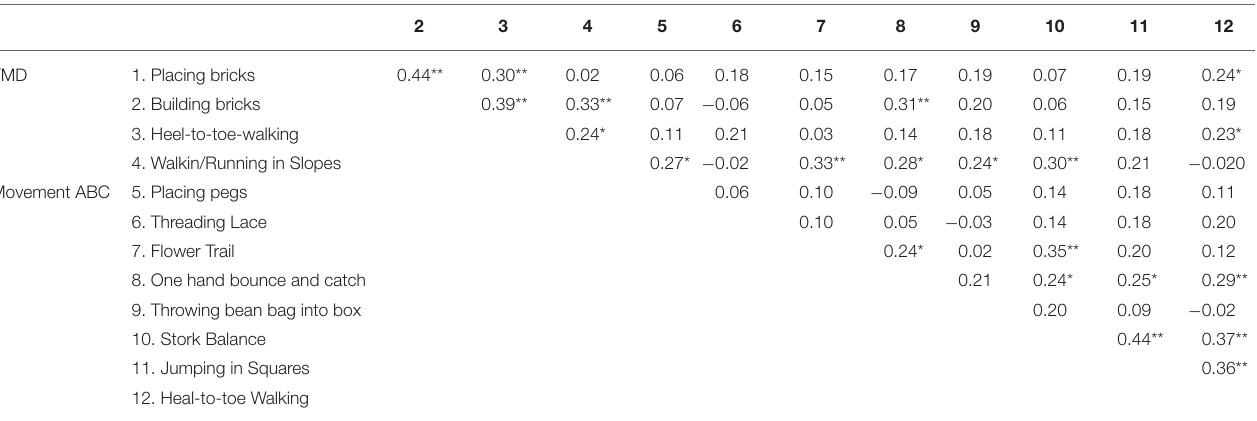
TABLE 4 | The intercorrelations (Pearsons) between performances in 12 motor tasks ( N =